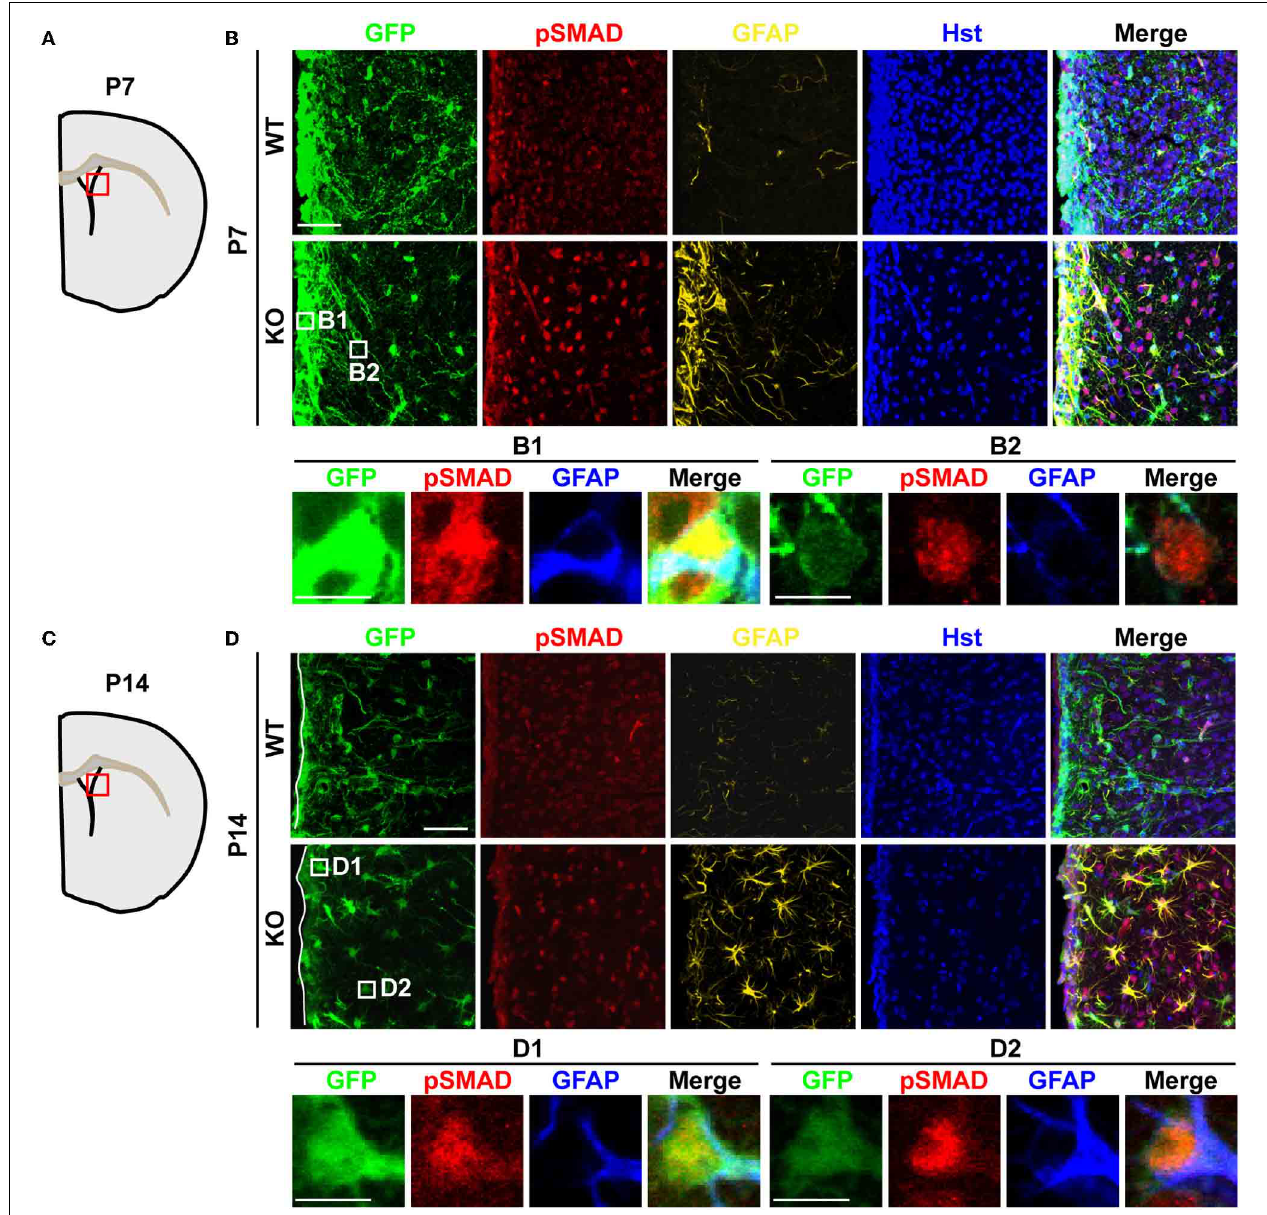
FIGURE 5 | Elevated BMP-SMAD signaling in Tlx -mutant brains. (A,C) Schematic diagrams depicting the brain regions analyzed. (B,D) Increased immunoreactivity of both pSMAD and GFAP in regions of the striatum and lateral ventricle of Tlx -mutant brains at P7 and P14 ( n = 3). NSCs and their